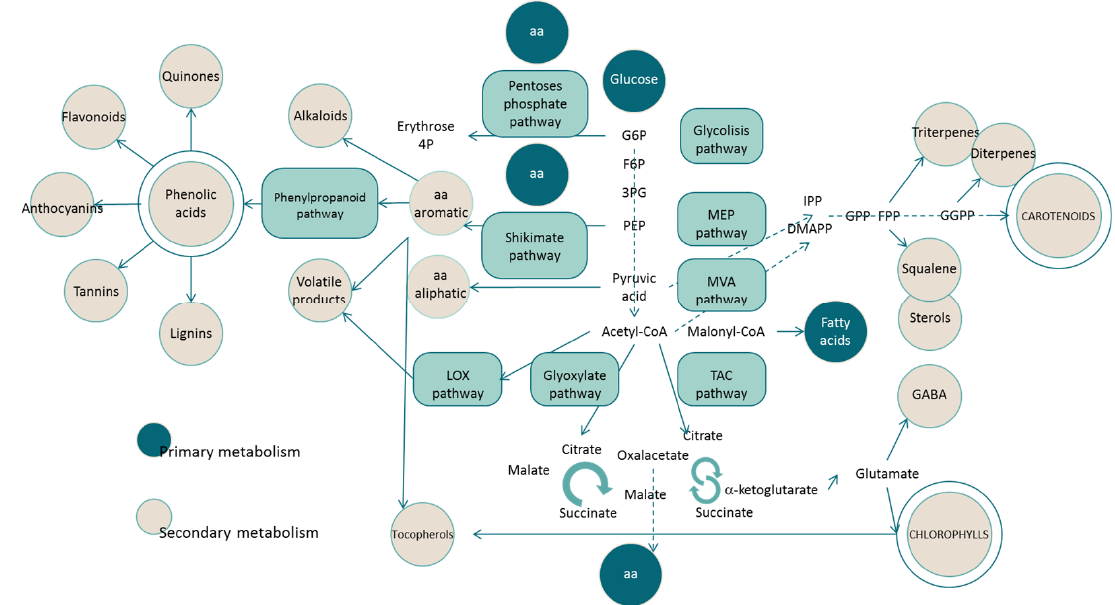
Figure 6. Brief description of some plant pathways and reaction processes that could be related to the biosynthesis and catabolism of chlorophyll and carotenoid pigments.